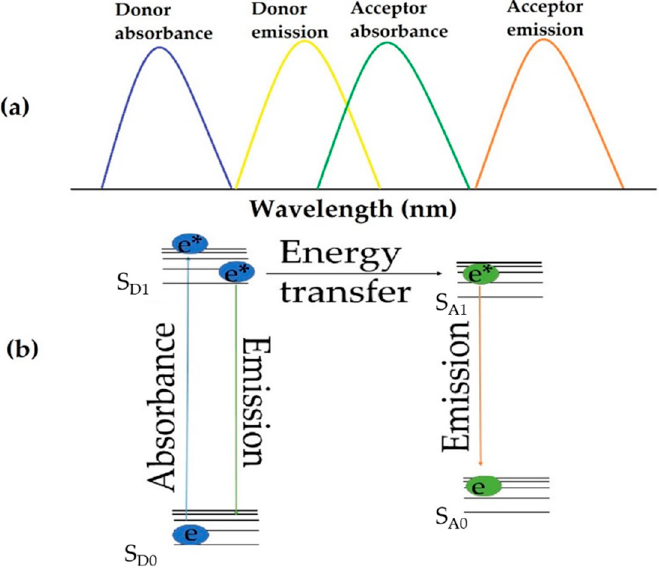
Figure 1. ( a ) Illustration of relationship between donor and acceptor spectra. ( b ) Energy diagram describing energy transfer via FRET mechanism.